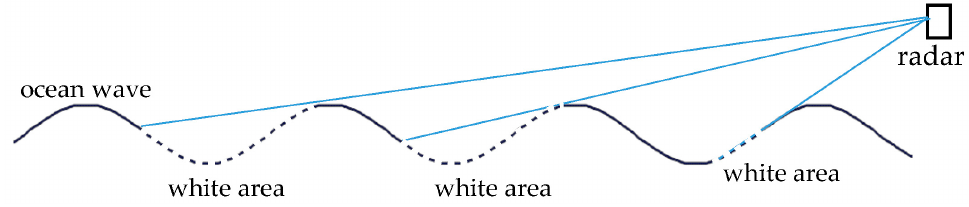
Figure 8. Size variation of white area. The solid parts of the curve are visible to the radar but the dashed parts are invisible.